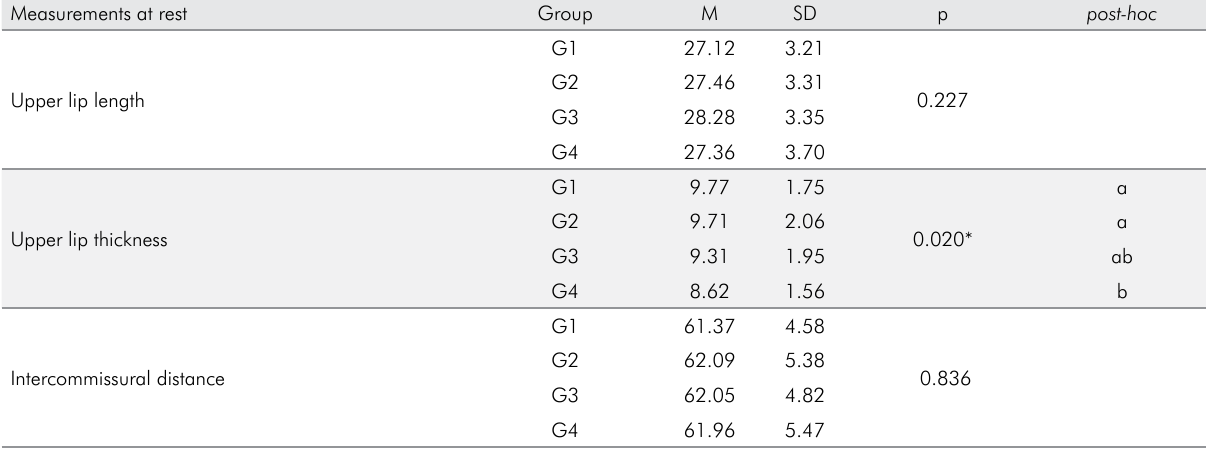
Table 2. Measurement results obtained by the group at rest, Mean (M), Standard Deviation (SD), p-value (p). Measurements at